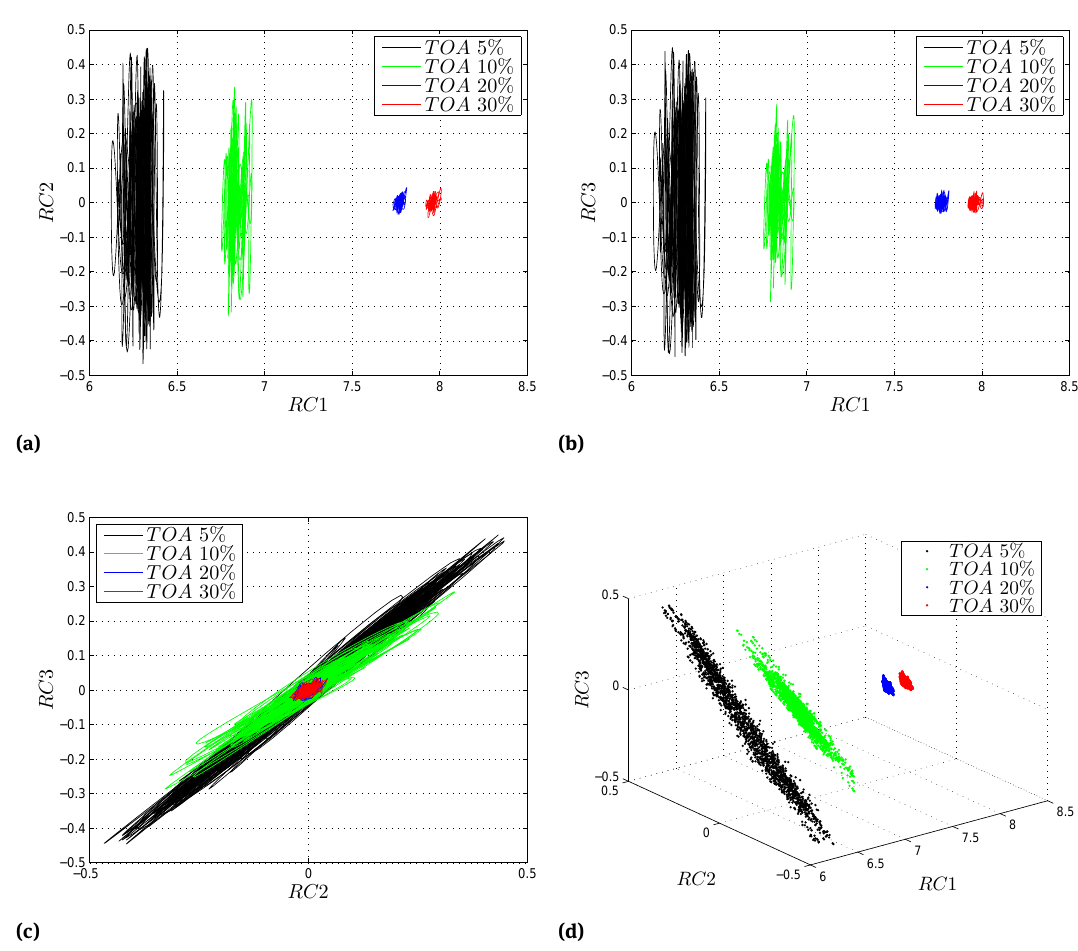
Figure 13: Phase portraits of the blower outlet signal on orthonormal basis created from the first three principal components